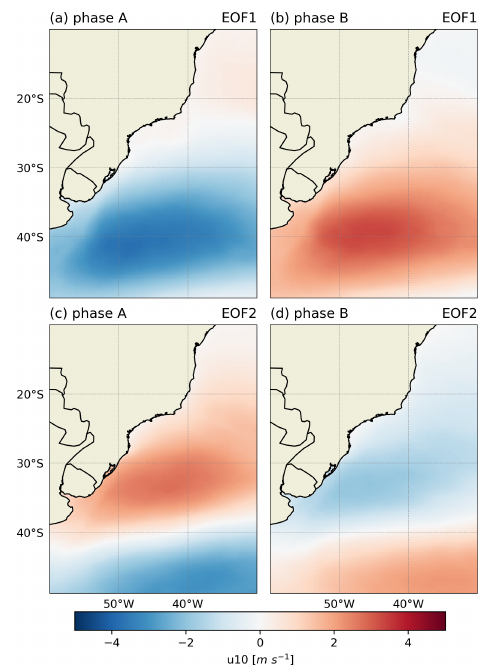
Figure C1. Composites of u 10 in phase A (a, c) and B (b, d) of the EOF1 (a, b) and EOF2 (c, d)